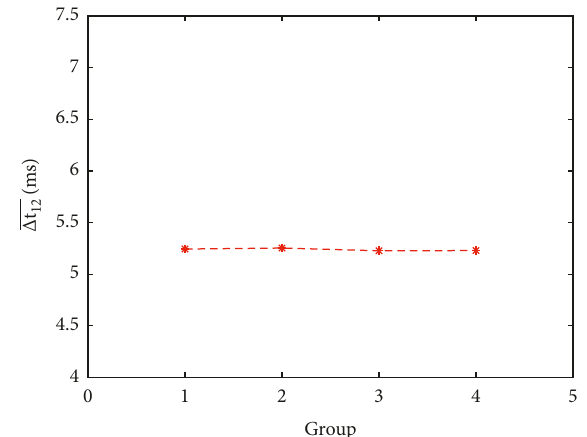
Figure 6: Distribution of the random delay sample mean ( Δ t